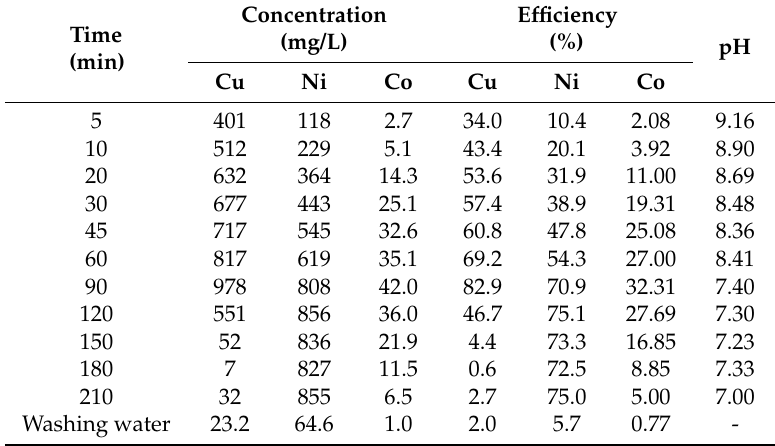
Table 7. Metals concentration and extraction efficiency of ammoniacal leaching with ultrasound at 85 °C. Concentration Time (mg/L) (min)